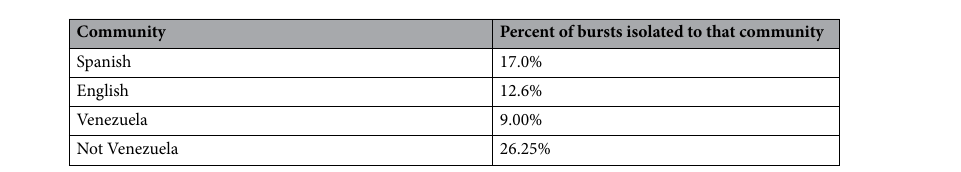
Table 4. The percentage of bursts across all information units that are isolated to each specific community. Overall, the majority of bursts cross community lines. Very few bursts occur only in the within-Venezuela community while more than a quarter occur only outside